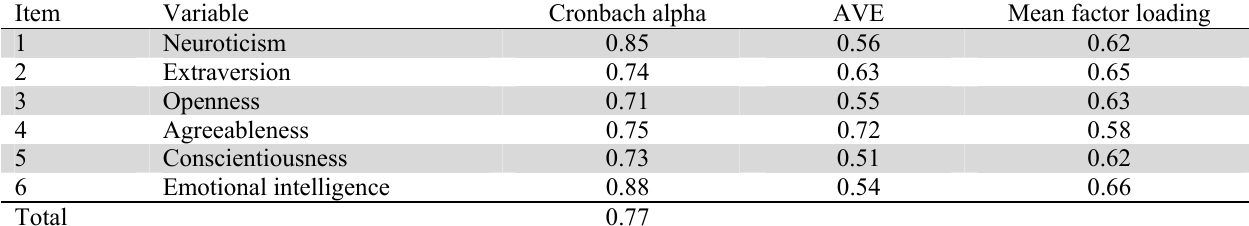
The summary of Cronbach alpha and AVE